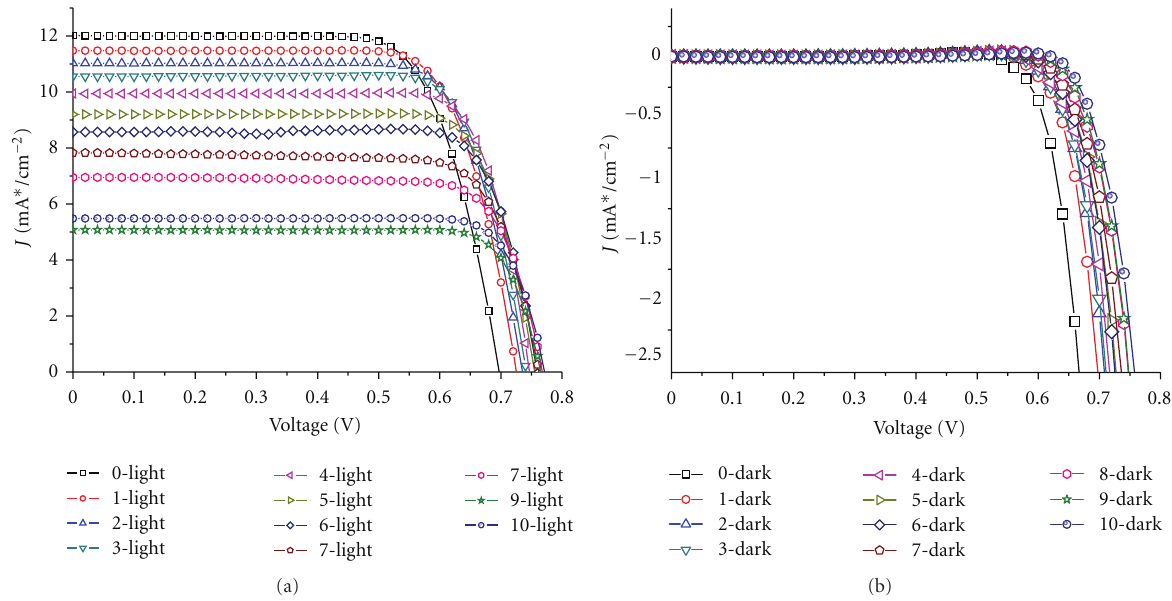
Figure 2: (a) Photocurrent density-voltage ( J - V ) characteristics of devices with electrolyte refreshing times under AM 1.5 illumination (100mW/cm). (b) J - V curves of the device with electrolyte refreshing times under dark condition.